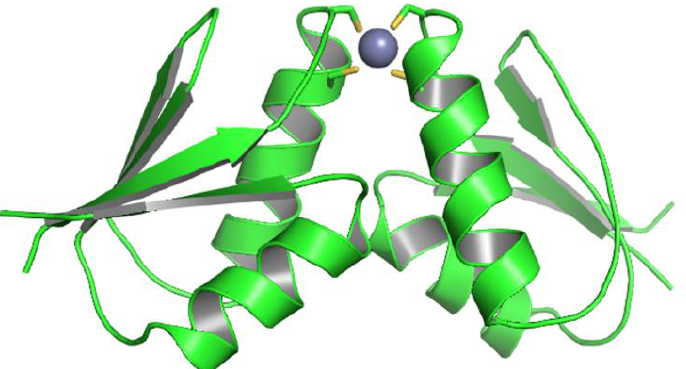
Figure 2. Crystal structure of the Atox1 dimer crystallized in the presence of ZnSO 4 (PDB code 7ZC3). The Atox1 molecules are shown in cartoon representation and the metal ion as a gray sphere. Protein residues within 3 Å from the metal are shown as sticks, with C and S atoms colored in green and yellow, respectively.